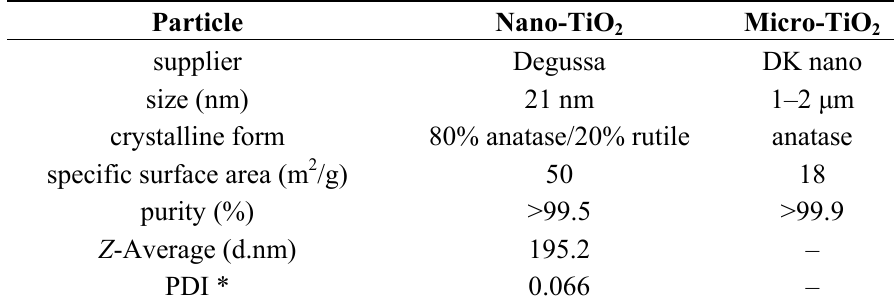
Table 1. Characterization of TiO